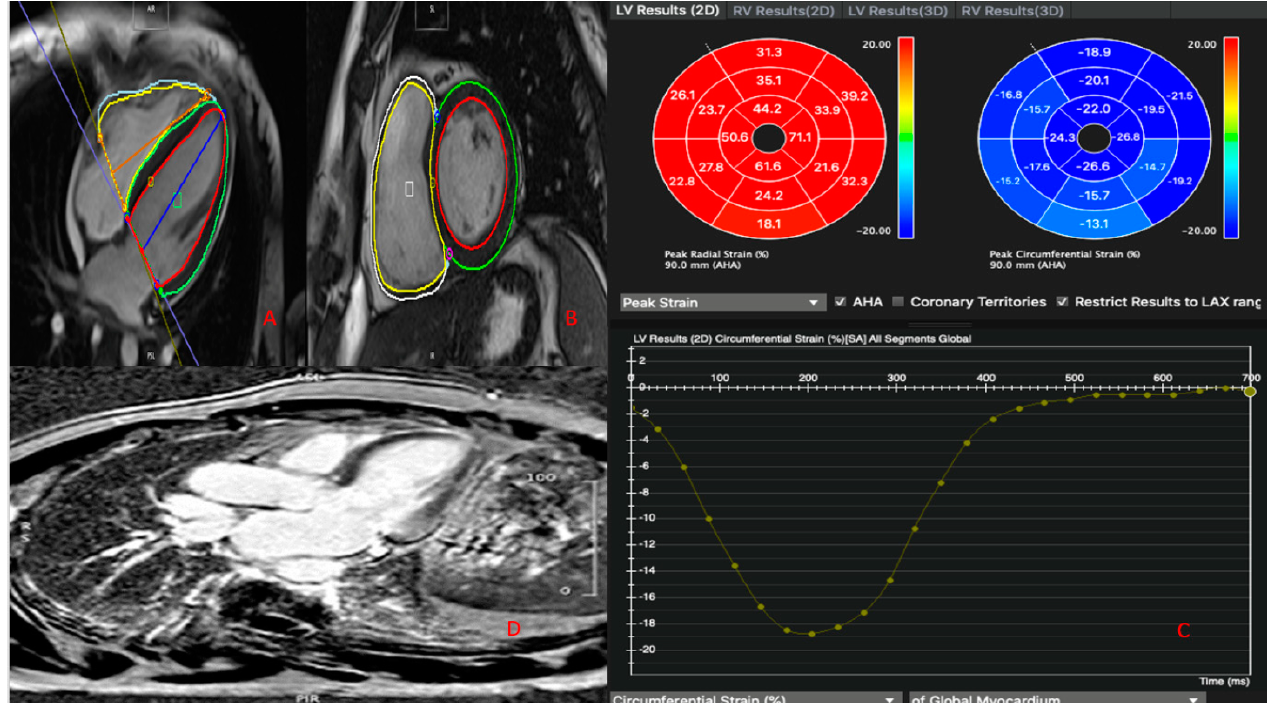
Figure 2. ( A ) Apical four-chamber CMR view. ( B ) Short-axis CMR view. The red and yellow lines trace the telediastolic endocardial border of the left and right ventricle, respectively. The green and white lines trace the telediastolic epicar- dial border of the left and right ventricle, respectively. ( C ) Two-dimensional LV radial and circumferential strain. The bullseyes show the average radial (red bullseye) or circumferential (blue bullseye) values for each of the 16 segments of the myocardium. The bottom of the figure shows the myocardial deformation curve. ( D ) Long-axis CMR view showing